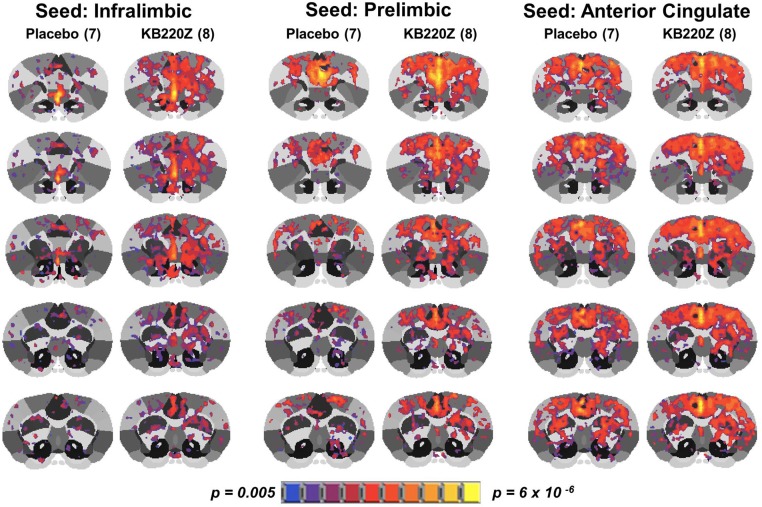
KB220Z effects resting state functional connectivity within the limbic cortex.Mean connectivity maps are at a threshold z value of 0.35 for visualization of resting state networks (scale bar indicates connectivity strength based on z value).